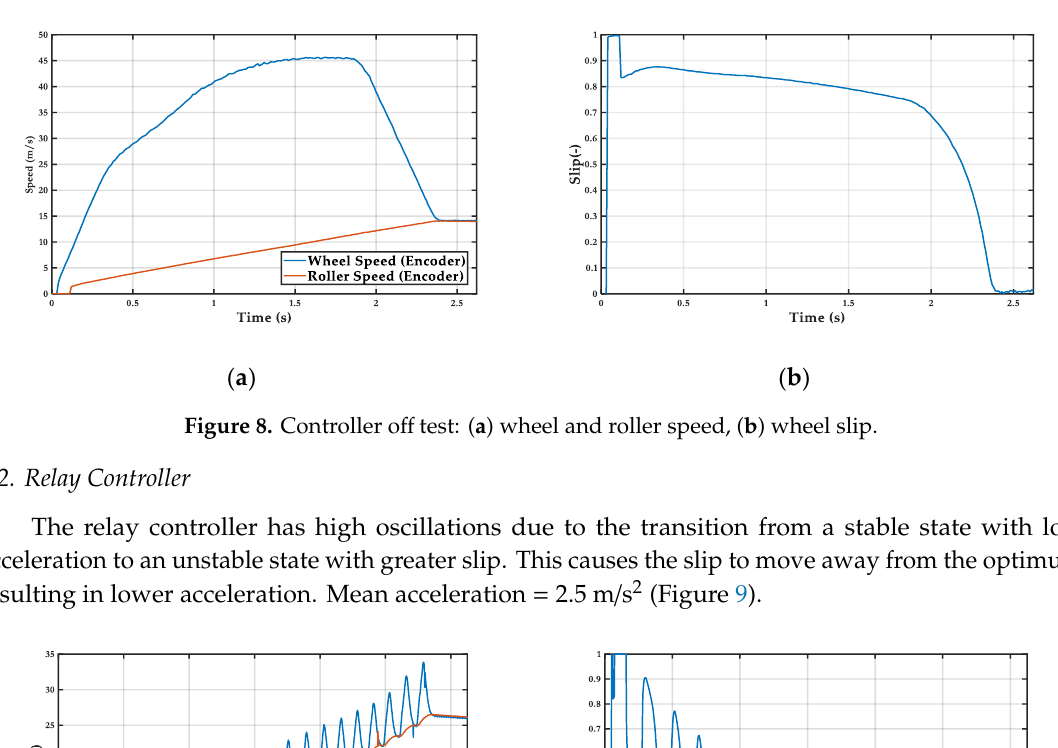
( b ) Figure 10. PID controller: ( a ) wheel and roller speed, ( b ) wheel slip. ( a ) ( b ) Figure 11. Fuzzy-logic controller: ( a ) wheel and ( b ) roller speed, wheel slip. 6. Conclusions and Future Work The development and validation of a real-time ECU was carried out in this work. Thanks to the use of modular programming, all the resources provided by the parallelism of the FPGA as well as by the dual-core processor were exploited. Therefore, the deadlines imposed by the system were met without the need for a complex real-time operating system. Furthermore, control was achieved with low-level language providing a very fast response that allowed the implementation of complex control algorithms from simulation platforms such as Simulink® . This low-cost ECU achieves the characteristics imposed to develop and implement control algorithms in vehicles, enabling the recording of the data obtained from sensors and installed actuators. All this allows us to implement